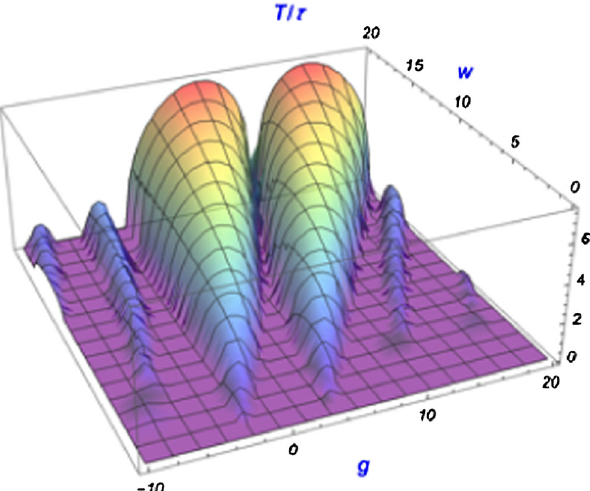
FIG. 1. Two-particle growth rate versus gain g and constant wake value w for reactive damper and zero chromaticity. All the values are in the units of the inverse synchrotron period 1 =T .